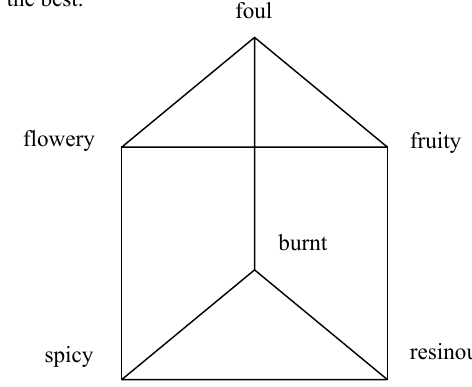
Fig. 1. Henning’s “smell prism”, source: Jezierski 1999, p.